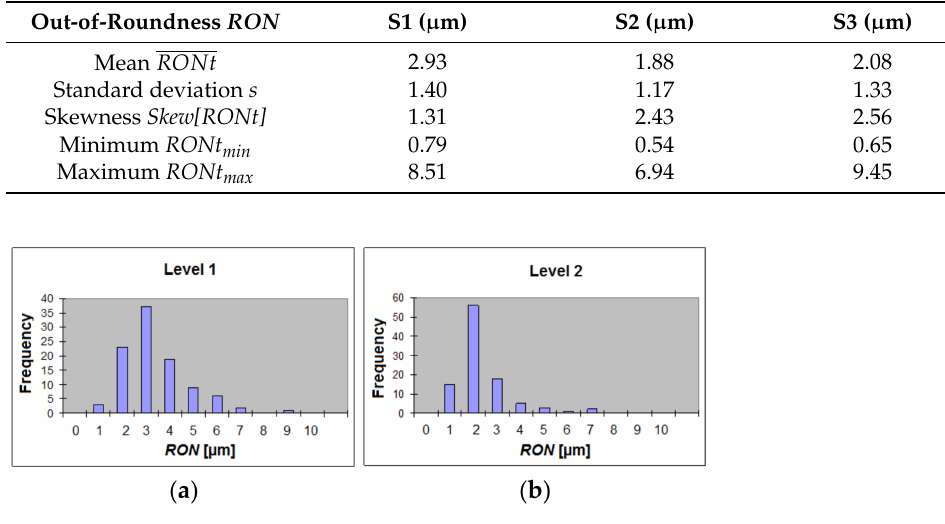
Figure 7. Histograms of out-of-roundness RONt achieved for: ( a ) Level 1; ( b ) Level